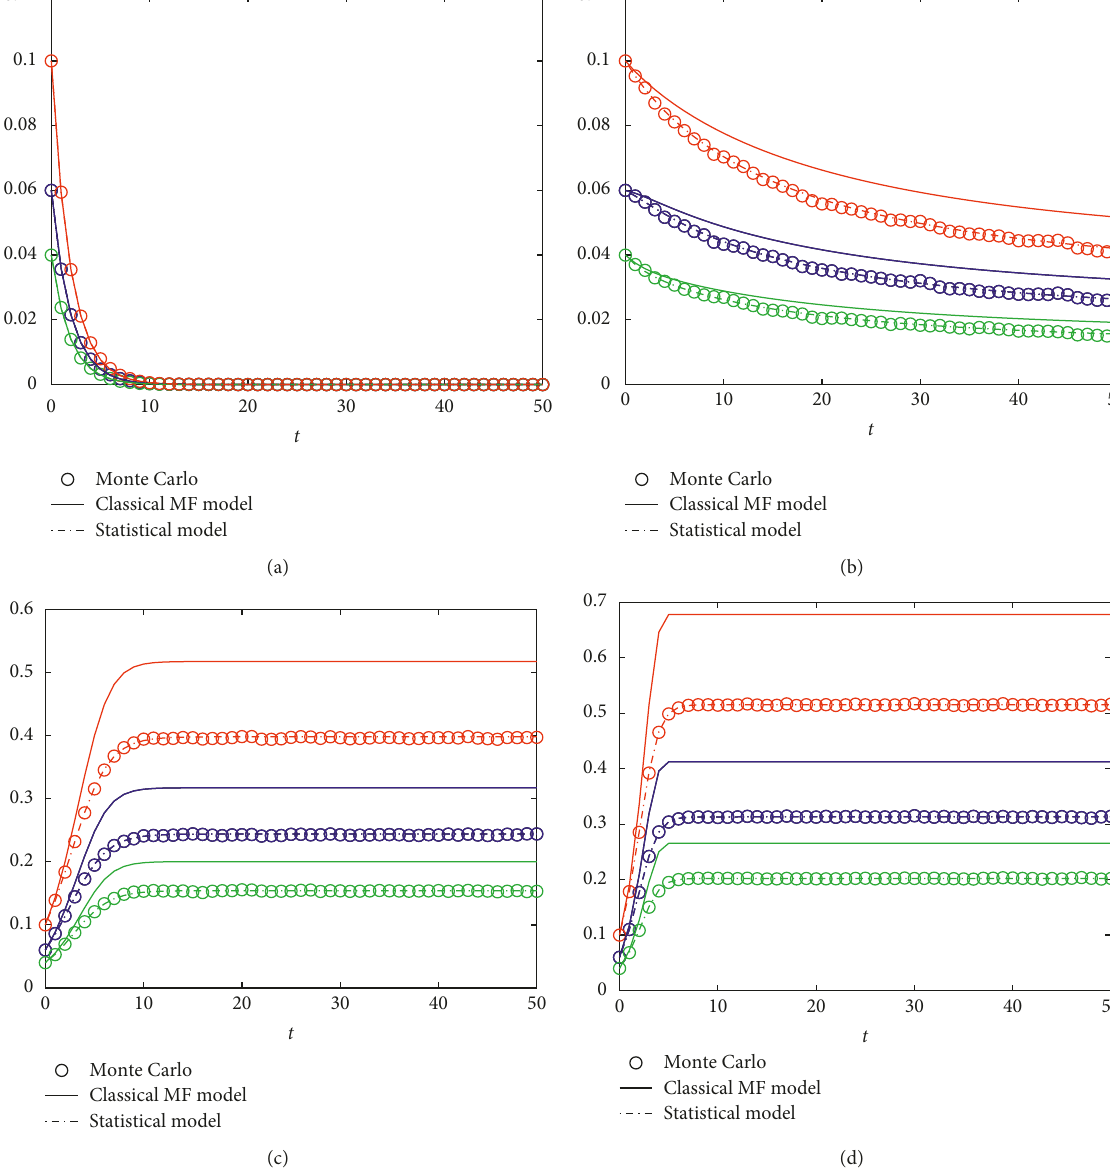
Figure 4: The time evolution of the fraction of infectious nodes of the type A (marked with blue), type B (marked with green), and both two types (marked with red). The circles, solid lines, and dotted lines represent the results of Monte Carlo simulations, the classical MF model, and the statistical model, respectively. (a) β � 0.01. (b) β � 0.05. (c) β � 0.1. (d) β �